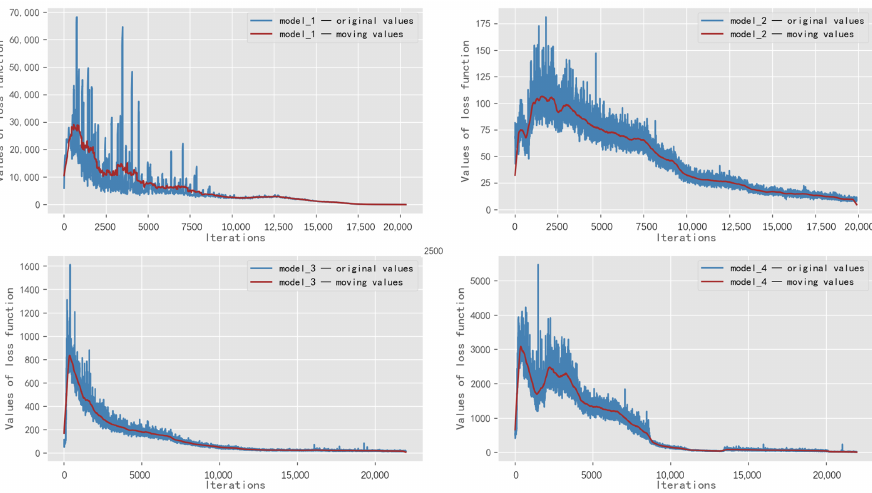
Figure 10. Variation of loss function for the four